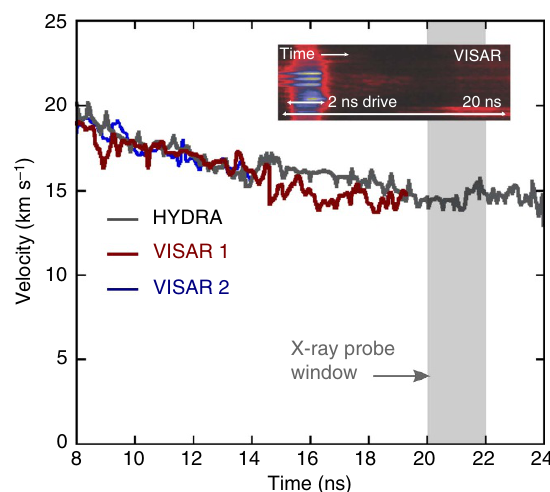
Figure 3 | VISAR shock velocity compares well with hydrodynamic simulations up to 20ns when the x-ray probe begins. We linearly extrapolate the mean velocity to obtain the average conditions during the x-ray probe. Uncertainty in shock velocity is estimated to be ± 1kms (cid:2) 1 ; uncertainty in timing is ± 0.5ns. Inset: raw VISAR streak for one of two streak cameras. The bright pulse early in time comes from the drive beam. Breakout of the shock from the aluminium pusher into the deuterium occurs near the end of the drive beam, and the decaying shock velocity in D 2 is extracted from the fringes shifting in